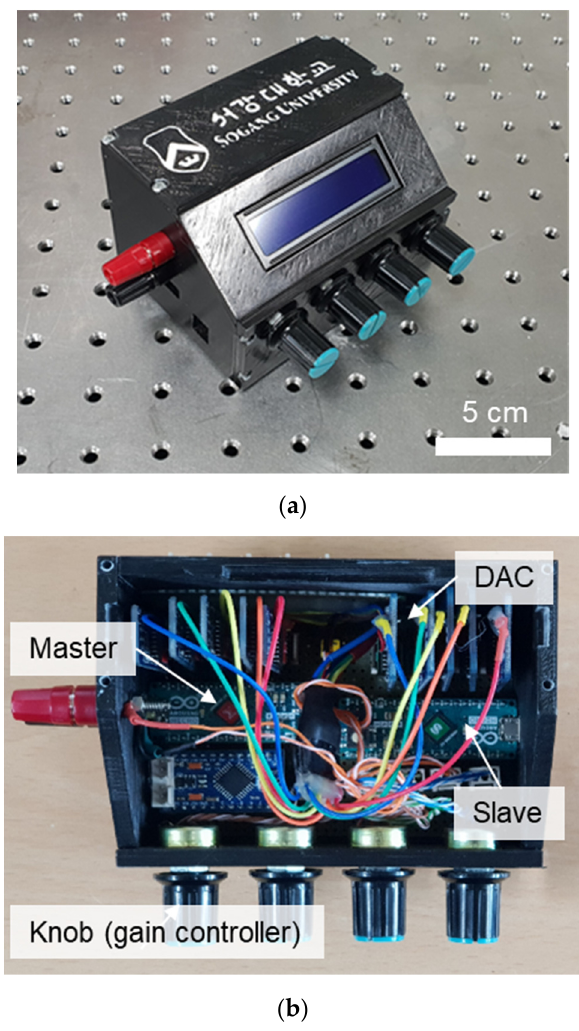
Figure 4. Photo of a custom-designed control module ( a ) and its inside view ( b ).